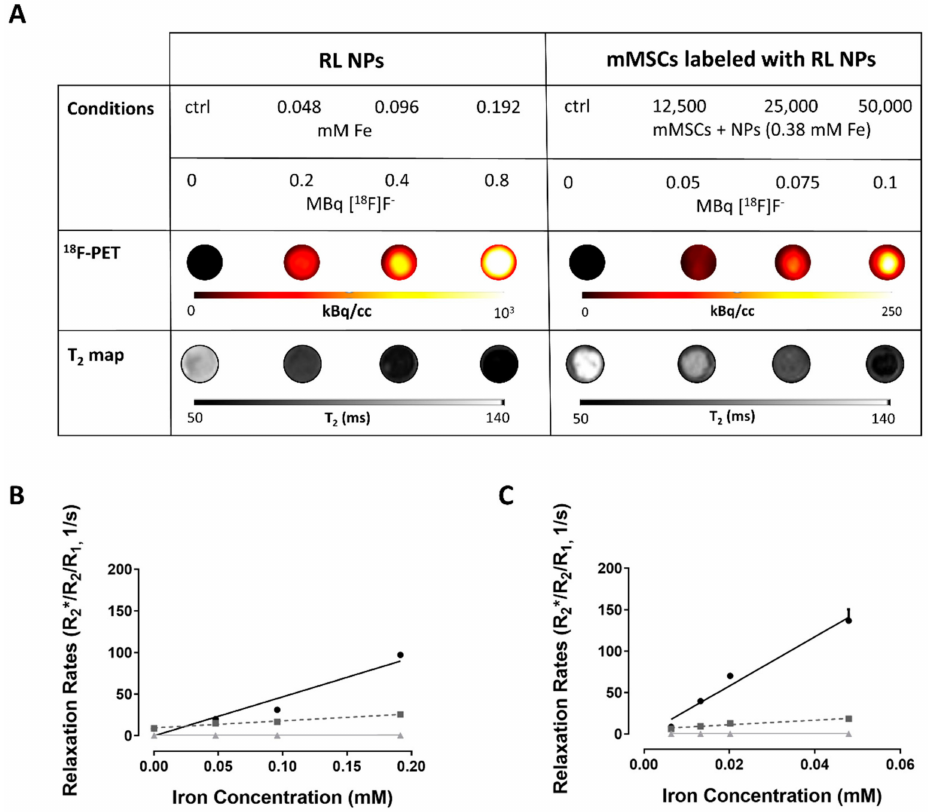
Figure 10. PET / MRI contrast properties of Fe 3 O 4 @Al(OH) 3 NPs labeled with [ 18 F]F - and mouse mesenchymal stem cells (mMSCs) labeled with such NPs: ( A ) Upper row: The di ff erent conditions measured with the estimated radioactivity present at the start of measurements. Samples (100 µ L) were diluted 1 with agar. Middle: 18 F-positron emission tomography (PET) images and Bottom: T 2 maps 2 of the agar phantoms loaded with either radiolabeled Fe 3 O 4 @Al(OH) 3 NPs (left) or mMSCs labeled with radiolabeled Fe 3 O 4 @Al(OH) 3 NPs (right). ( B , C ) Relaxation rate (R 1 / 2 / 2 *) plotted against ( B ) iron concentration (mM) of Fe 3 O 4 @Al(OH) 3 NPs or ( C ) intracellular iron concentration (mM) of mMSCs labeled with di ff erent amounts of radiolabeled Fe 3 O 4 @Al(OH) 3 NPs. The following cell densities were studied: 12,500, 25,000, and 50,000 cells in 200 µ L: 62,500 cells / mL, 125,000 cells / mL, and